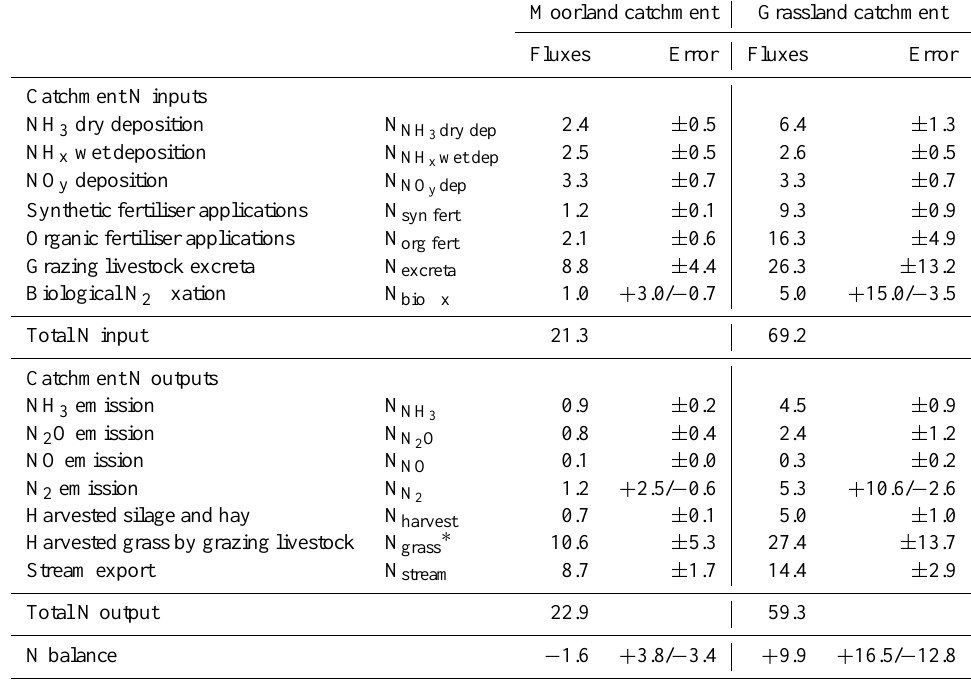
Table 3. Soil N budgets for the Moorland (621ha) and the Grassland (895ha) catchment with fluxes and errors shown in kgNha − 1 yr − 1 (see subsections under Sects. 2.3 and 2.4 for details of individual error